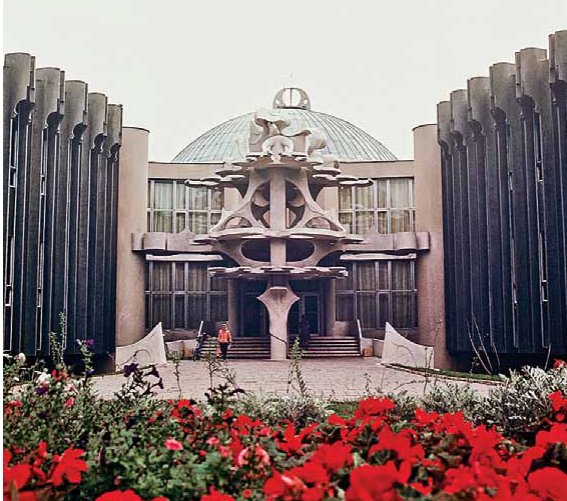
Fig. 1. Balneophysiotherapy sanatorium in Druskininkai (archit. aušra and juozas Šilinskai, 1981, cur. Druskininkai aquapark)